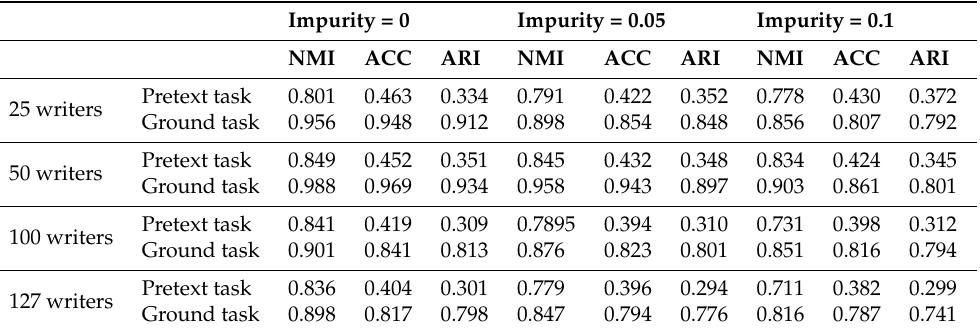
Table 3. The table illustrates the pairwise architecture in the IAM dataset across four-speaker groups: 25, 50, 100, and 127. The table also analyzes two segmentation impurities, 0 and 0.1, for each group of writers to illustrate the shortcomings of the faulty assumption.